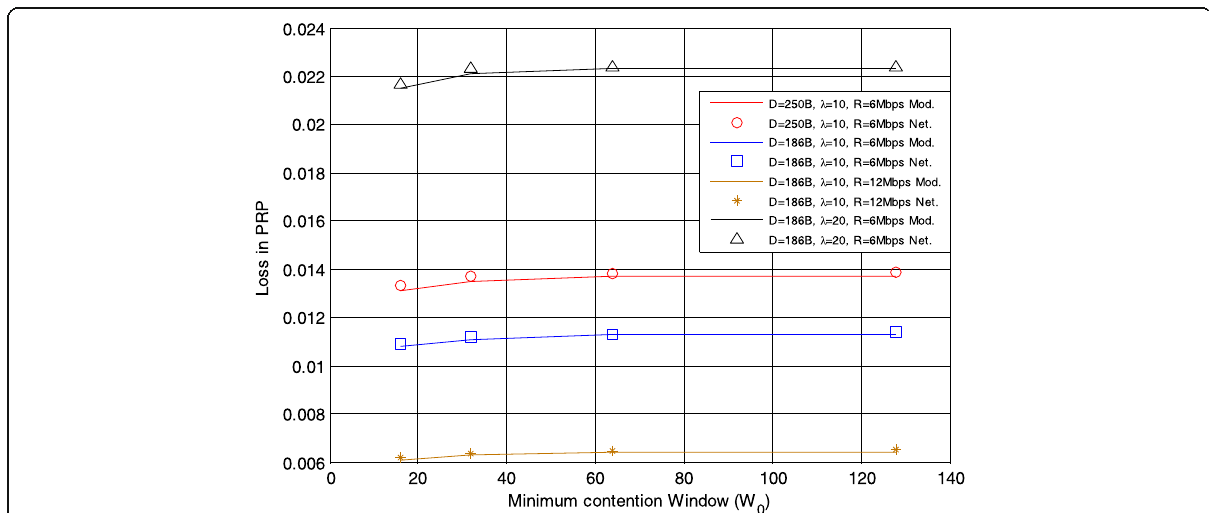
Fig. 16 Loss in the PRP due to hidden terminals for the analytical model (Mod.) and real network in Fig. 8 (Net.) with respect to minimum contention window size for the various network parameters, R c = 250